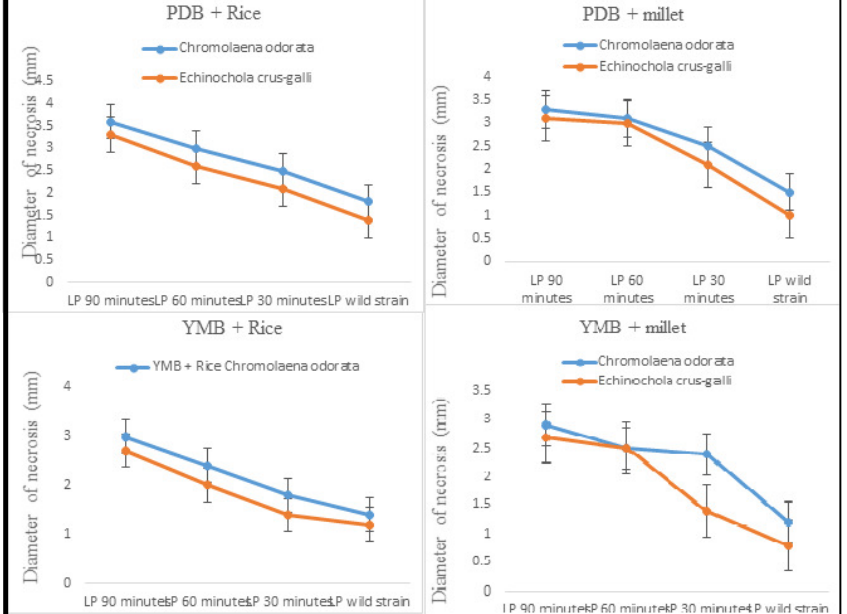
Fig. 2. Effect of biphasic system on necrotic induction from wild and mutant strains of C1136; (A) Diameter of necrosis induced by Lp90; (B) Diameter of necrosis induced by Lp60; (C) Diameter of necrosis induced by Lp30; (D) Diameter of necrosis induced by Lp wild strain